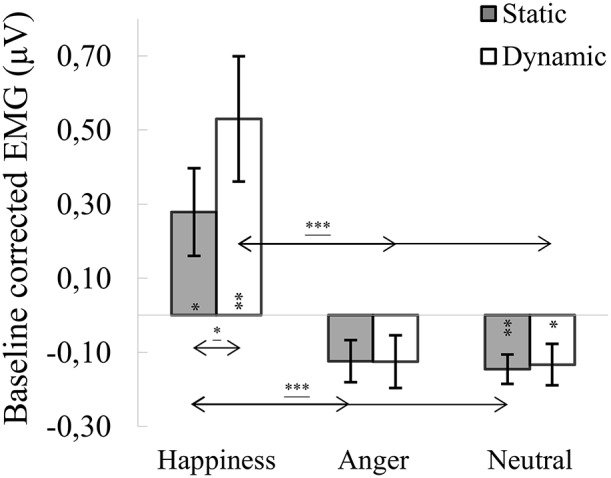
Mean (±SE) EMG activity changes and corresponding statistics for zygomaticus major during presentation conditions. Asterisks with lines beneath indicate significant differences between conditions (simple effects) in EMG responses: *p < 0.05, ***p < 0.001. Separate asterisks indicate significant differences from baseline EMG responses: *p < 0.05, **p < 0.01.